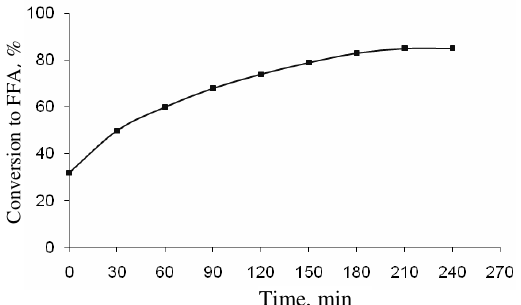
Figure 2. Time course of waste cooking oil hydrolysis catalyzed by pH-tuned plus TPP enhanced lipase enzyme. (The reaction was carried out using an oil/buffer ratio of 2:1 (w/w), pH 8 and at 40 o C).